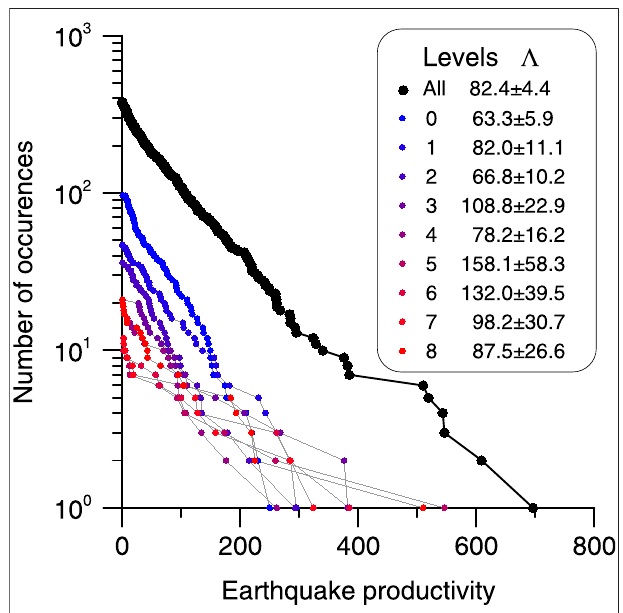
FIGURE 2 | Cumulative frequency-productivity graphs for parent earthquakes with M m ≥ 6 and offspring events with M a ≥ M m − 5.